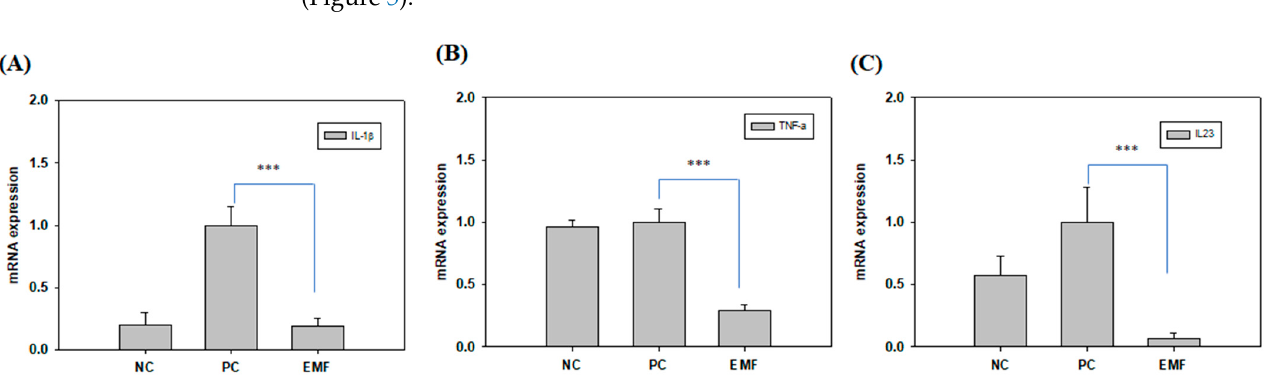
Figure 4. EMF regulates the expression of osteoclastogenic markers. Expression levels of ( A ) RANK, ( B ) TRAP, ( C ) CTSK, and ( D ) MMP9 were determined by RT-qPCR in Raw 264.7 cells differentiated for 4 days in differentiation media (with RANKL) with or without EMF exposure. NC, cells grown in growth media (undifferentiated); PC, cells grown in differentiation media (with RANKL); EMF, cells grown in differentiation media (with RANKL) with EMF exposure. The symbols * and *** indicate significant differences with p < 0.05 and p < 0.005, respectively.